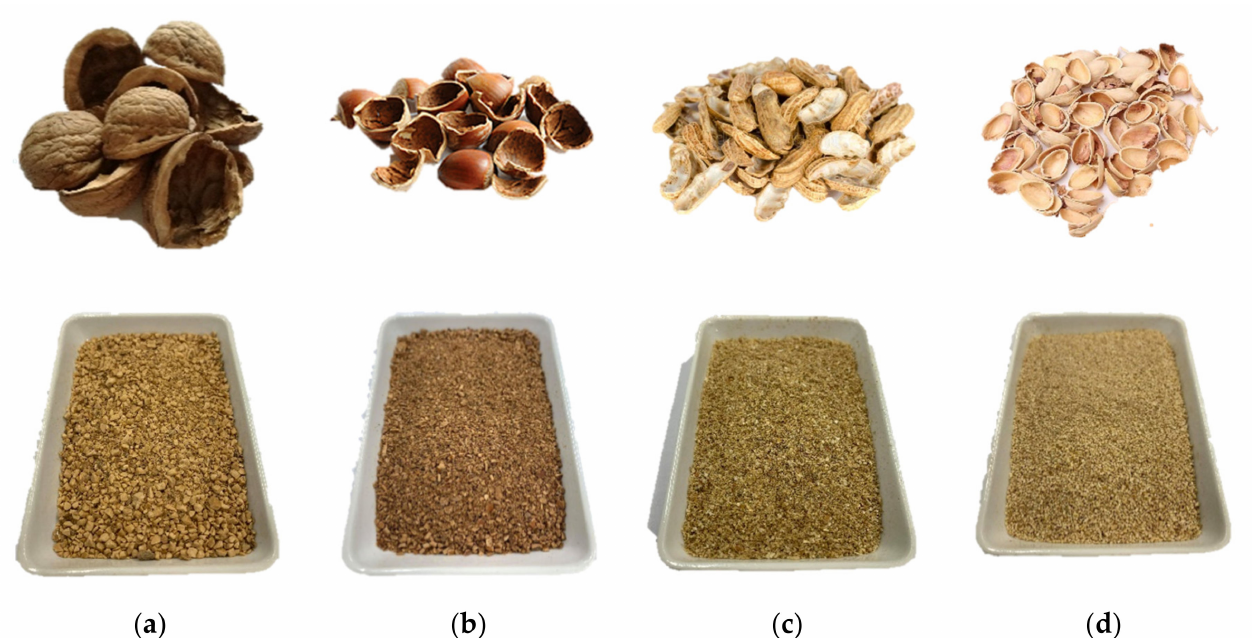
Figure 2. Waste biomass (nut shells) used in experiments: walnut ( a ), hazelnut ( b ), peanut ( c ), and pistachio ( d ).